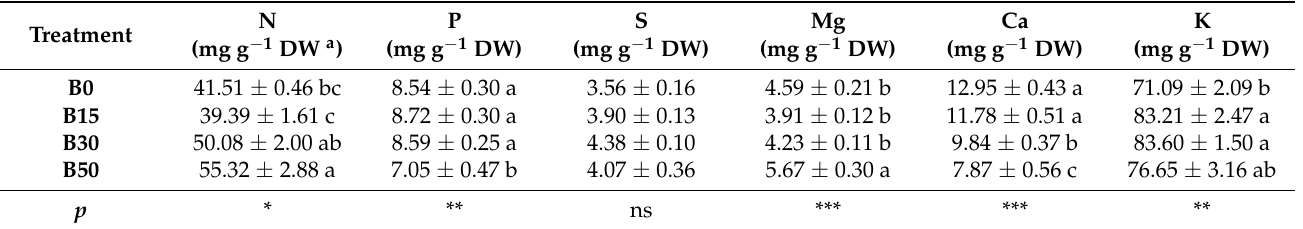
Table 7. Macronutrient (N, P, S, Mg, Ca and K) content detected in shoots of lettuce grown on different biochar:peat substrates.